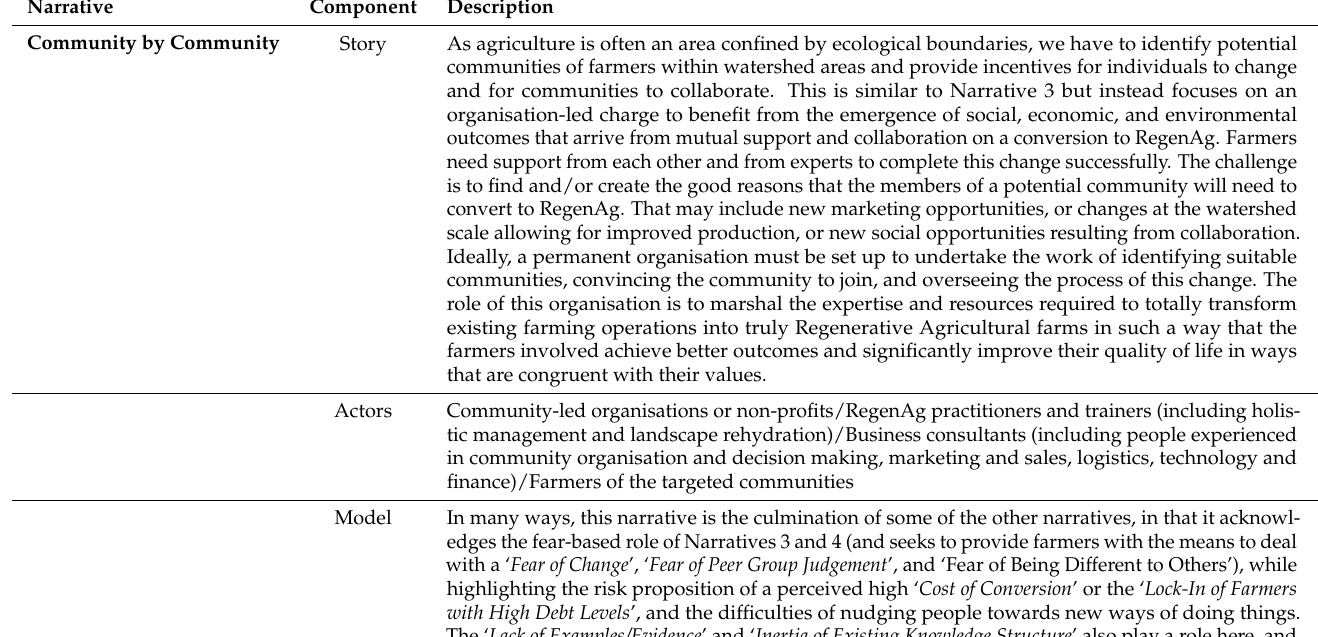
Table 7. Narrative 5: Community by